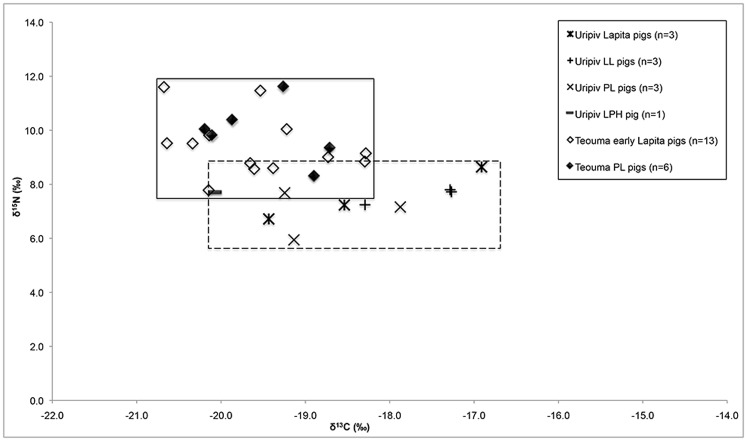
Comparison of bone collagen 13C and δ15N values of Uripiv and Teouma pigs.